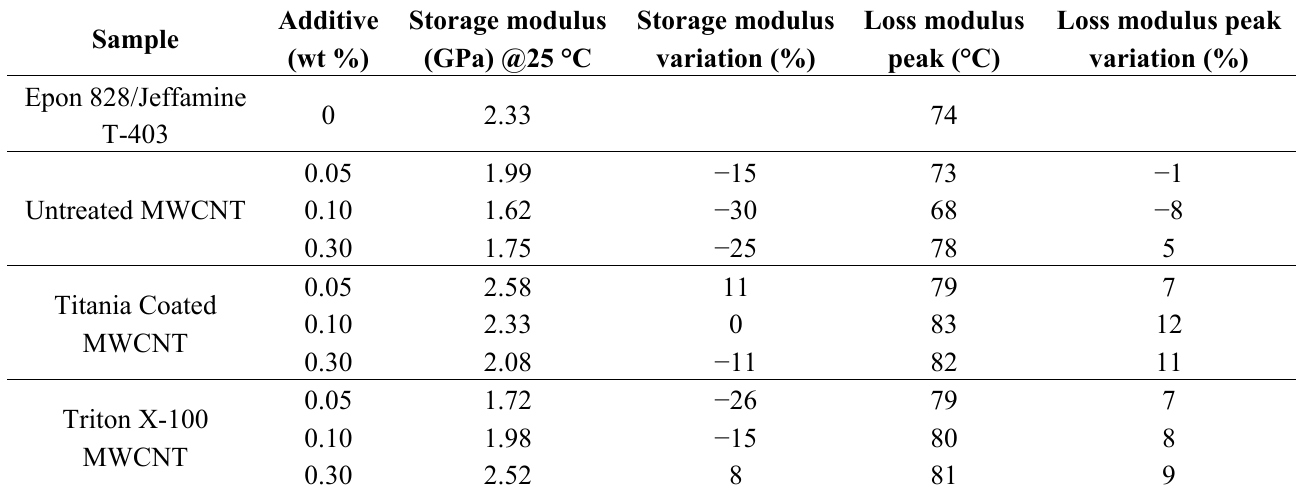
Table 6. Epoxy system 1: Thermo-mechanical properties of nanocomposites.